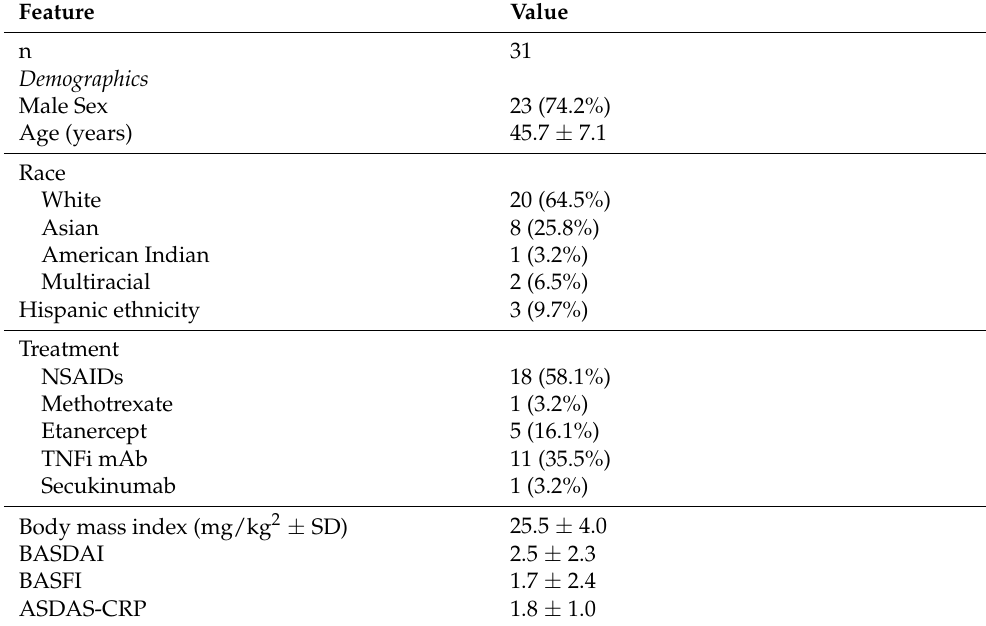
Table 1. Clinical features of ankylosing spondylitis probands. Abbreviations: ASDAS-CRP, anky- losing spondylitis disease activity score—C reactive protein; BASDAI, Bath ankylosing spondylitis disease activity index; BASFI, Bath ankylosing spondylitis functional index; NSAIDs, nonsteroidal anti-inflammatory drugs.